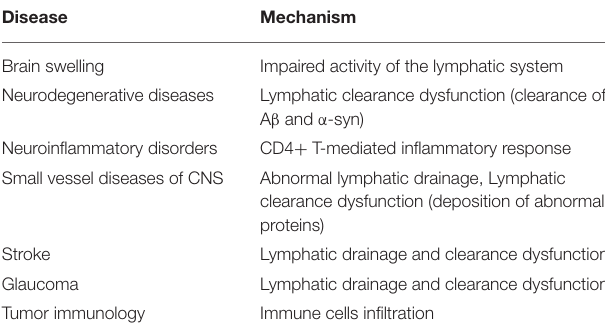
TABLE 1 | Lymphatic circulation of the central nervous system (CNS) and its related